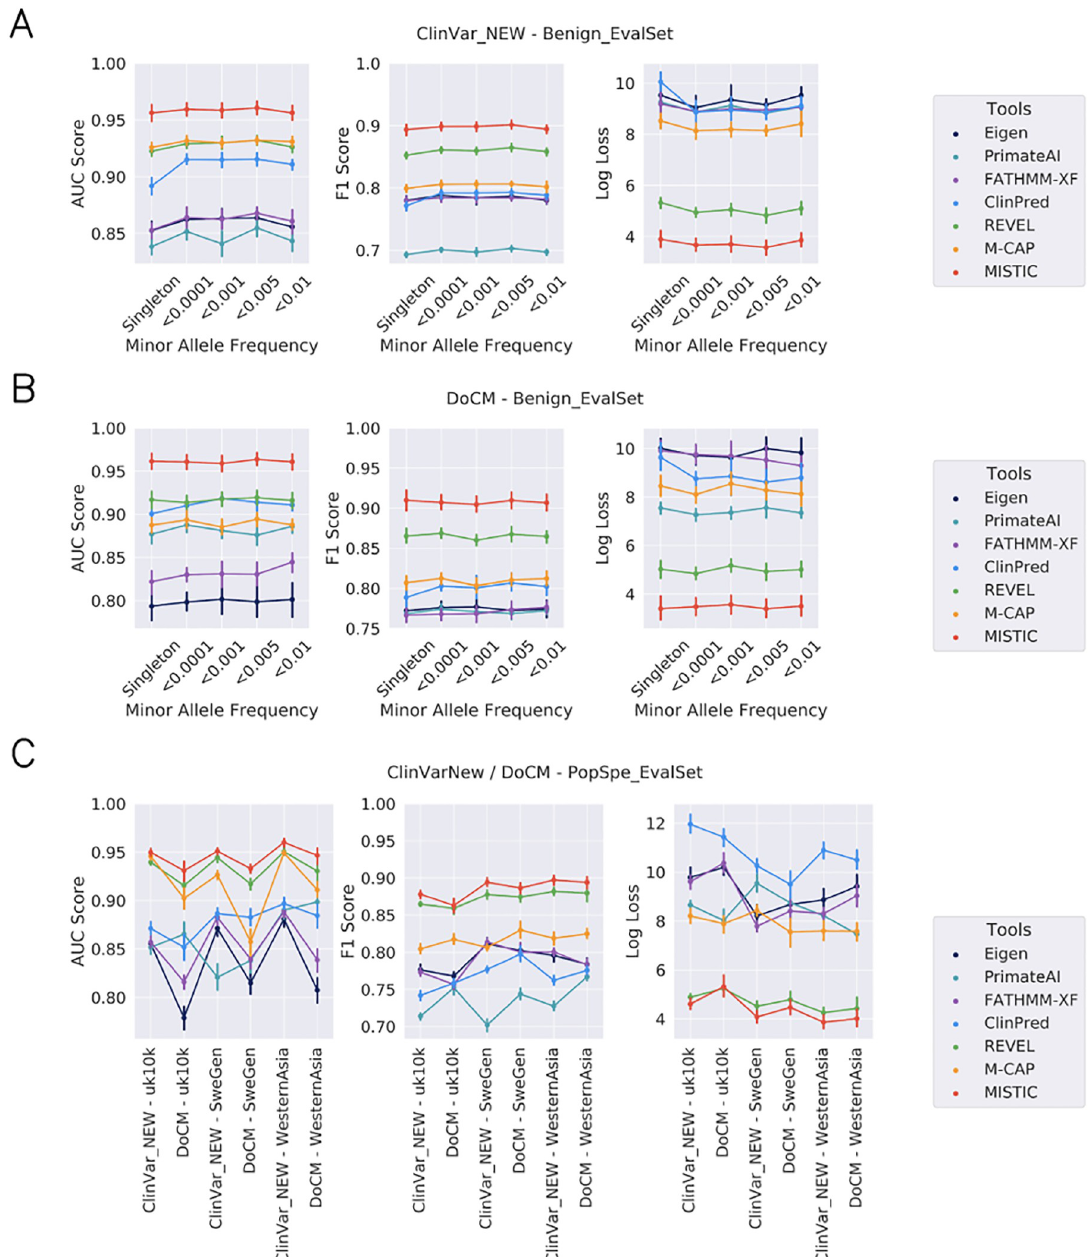
Fig 2. Evaluation of prediction tools on different variant analysis scenarios. The performance of MISTIC was compared to other missense prediction tools for the discrimination of deleterious variants from rare benign variants and population-specific missense variants. All prediction tools were evaluated using novel deleterious variants (Fig 2A - ClinVarNew and Benign_EvalSet set), known deleterious variants from diverse sources (Fig 2B - DoCM and Benign_EvalSet set), rare benign variants with MAF data ( < 0.01, < 0.005, < 0.001, < 0.0001, singleton) or benign variants without MAF (ClinVarNew/DoCM and PopSpe_EvalSet: UK10K, SweGen, WesternAsia; Fig 2C).